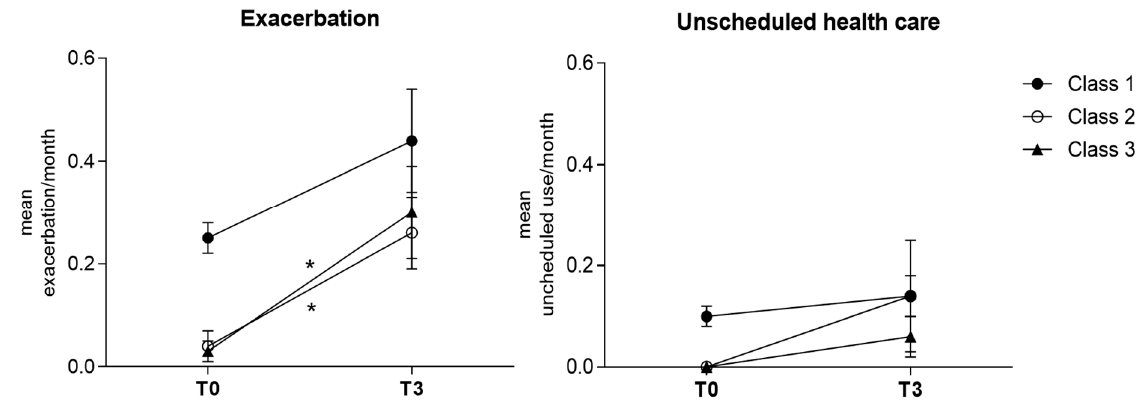
Figure 2. Longitudinal changes in the rate of exacerbations and unscheduled healthcare visits per month, among the three classes. Error bars indicating standard error of the mean. Number of subjects with exacerbations: class 1 (T0: n = 81; T3: n = 33), class 2 (T0: n = 3; T3: n = 10) and class 3 (T0: n = 3; T3: n = 16). Number of subjects with unscheduled healthcare visits: class 1 (T0: n = 49; T3: n = 12), class 2 (T0: n = 0; T3: n = 2) and class 3 (T0: n = 0; T3: n = 3). * significant for p < 0.01. T0: baseline assessment; T3: 4-month follow-up.